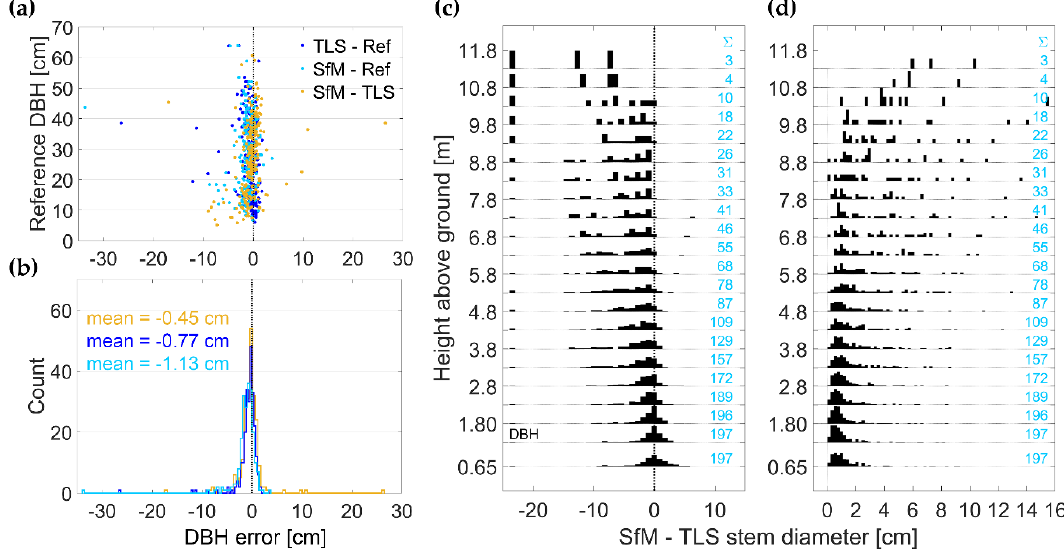
Figure A4. For all the forest plots, the DBH errors for SfM and TLS in comparison to the reference measurements show as ( a ) scatterplot and ( b ) histogram. The histogram for each height above the ground of ( c ) the SfM stem diameter error and ( d ) the offset of the stem centre between SfM and TLS. In light blue, the total number of estimated diameters for every height above the ground.